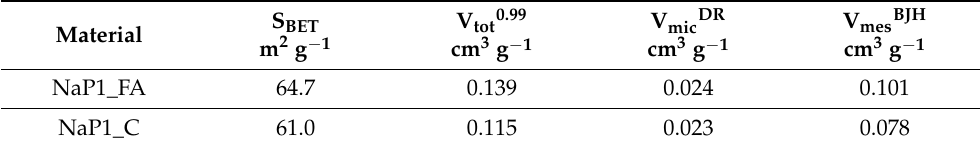
Table 2. The textural parameters of obtained zeolitic materials.